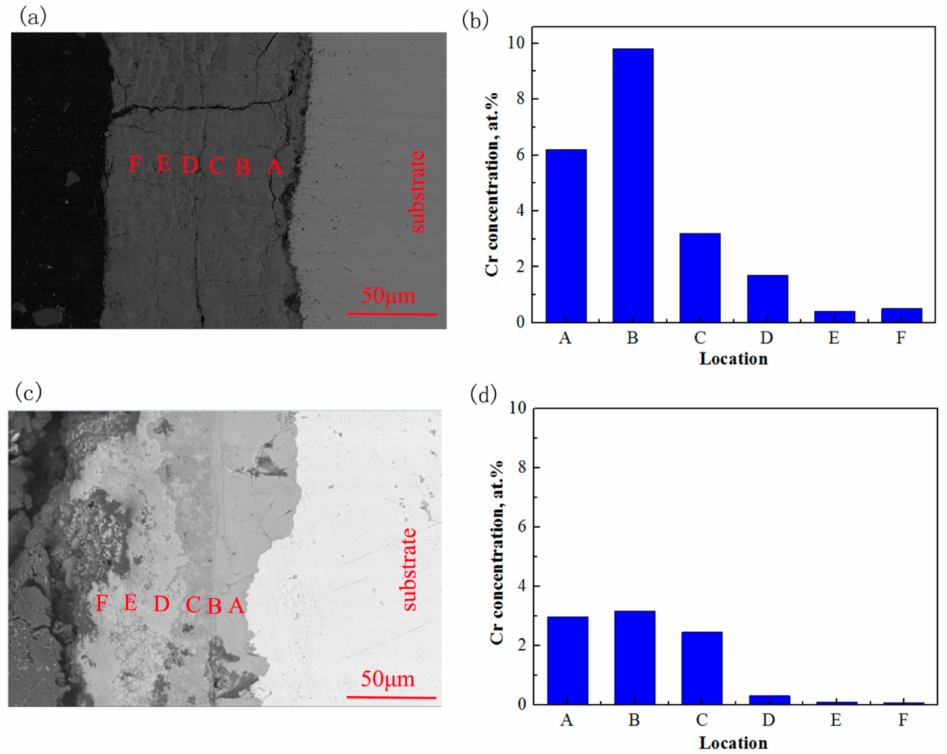
Figure 8. Cross-section morphologies and Cr elements concentration of erosion-corrosion product ( a ) P CO2 : 2.5 MPa, Cross-section morphology, ( b ) P CO2 : 2.5 MPa, Cr element concentration, ( c ) P CO2 : 2.5 MPa, P O2 : 0.6 MPa, Cross-section morphology, ( d ) P CO2 : 2.5 MPa, P O2 : 0.6 MPa, Cr element